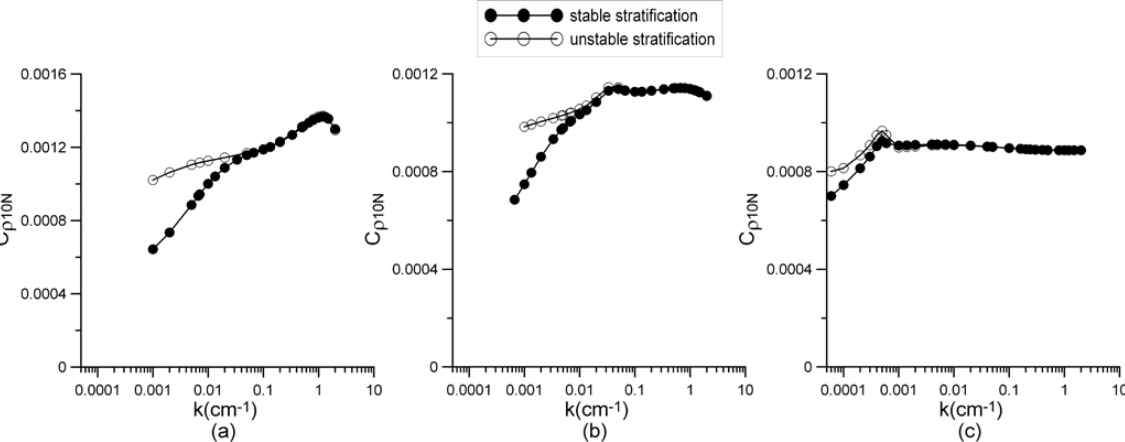
Fig. 9. Dependencies of the mass exchange coefficient of the water surface on the wave length for u ∗ = 5cms − 1 (a) , u ∗ = 10cms − 1 (b) , u ∗ = 50cms − 1 (c) .